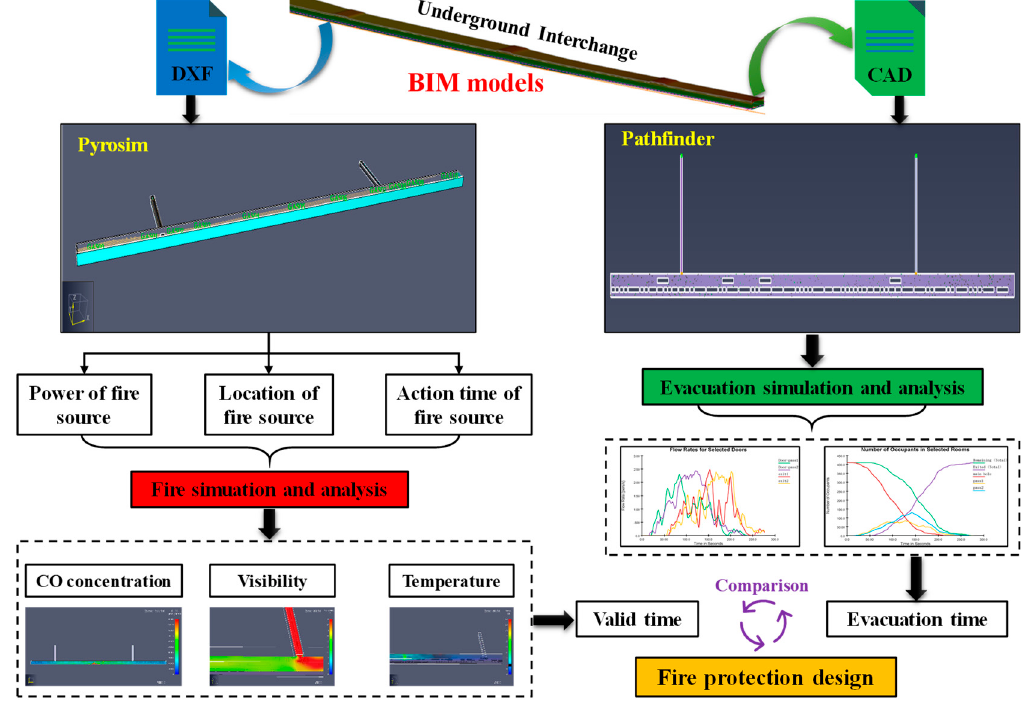
Figure 1. Technology roadmap of BIM modeling and fire simulation in underground interchange tunnels.